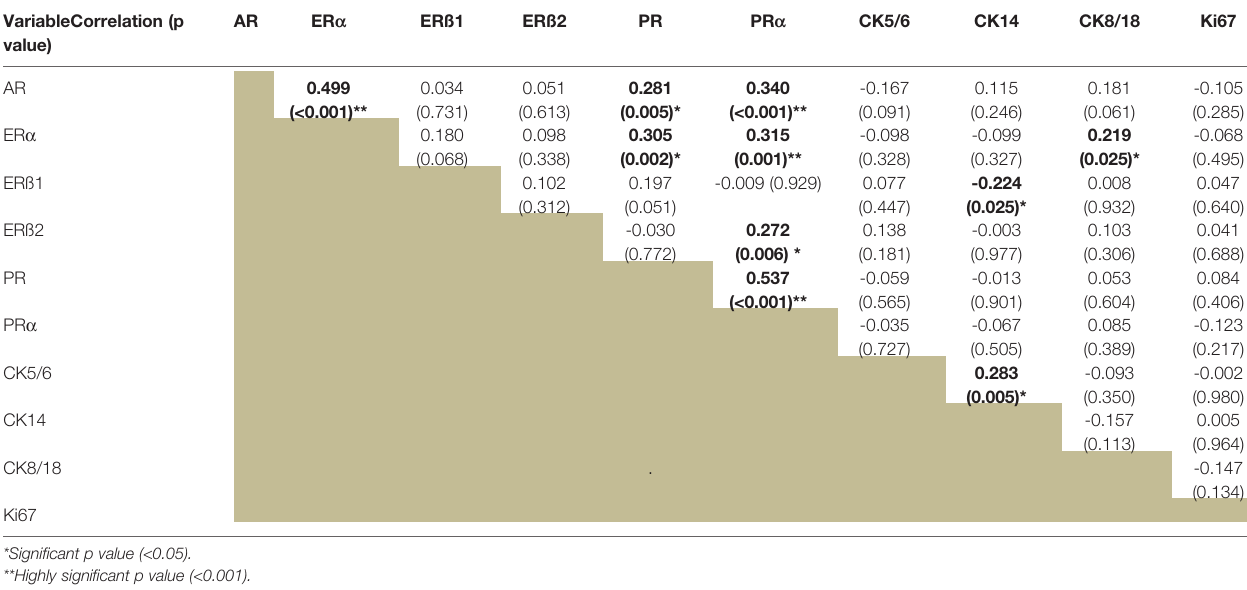
TABLE 5 | Correlation between biomarkers ’ expression.